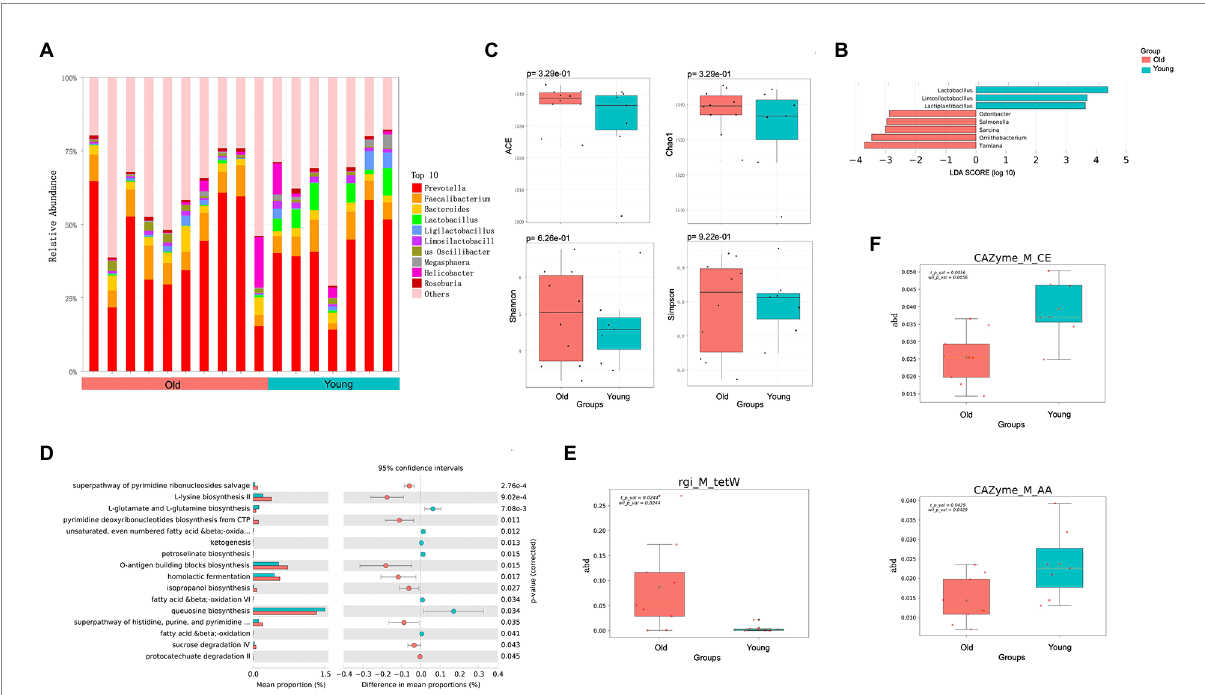
FIGURE 1 Metagenomics analysis of gut microbiota. (A) Top 10 most abundant genera in gut microbiome between young and old groups. (B) Differential analysis of gut microbial composition in young and old groups. (C) Alpha ( α ) diversity estimates between young and old groups. (D) Differential analysis of gut microbial function in young and old groups. (E) Differential analysis of gut microbial ARGs in young and old groups. (F) Differential analysis of gut microbial CAZy enzyme in young and old groups. p < 0.05 was considered